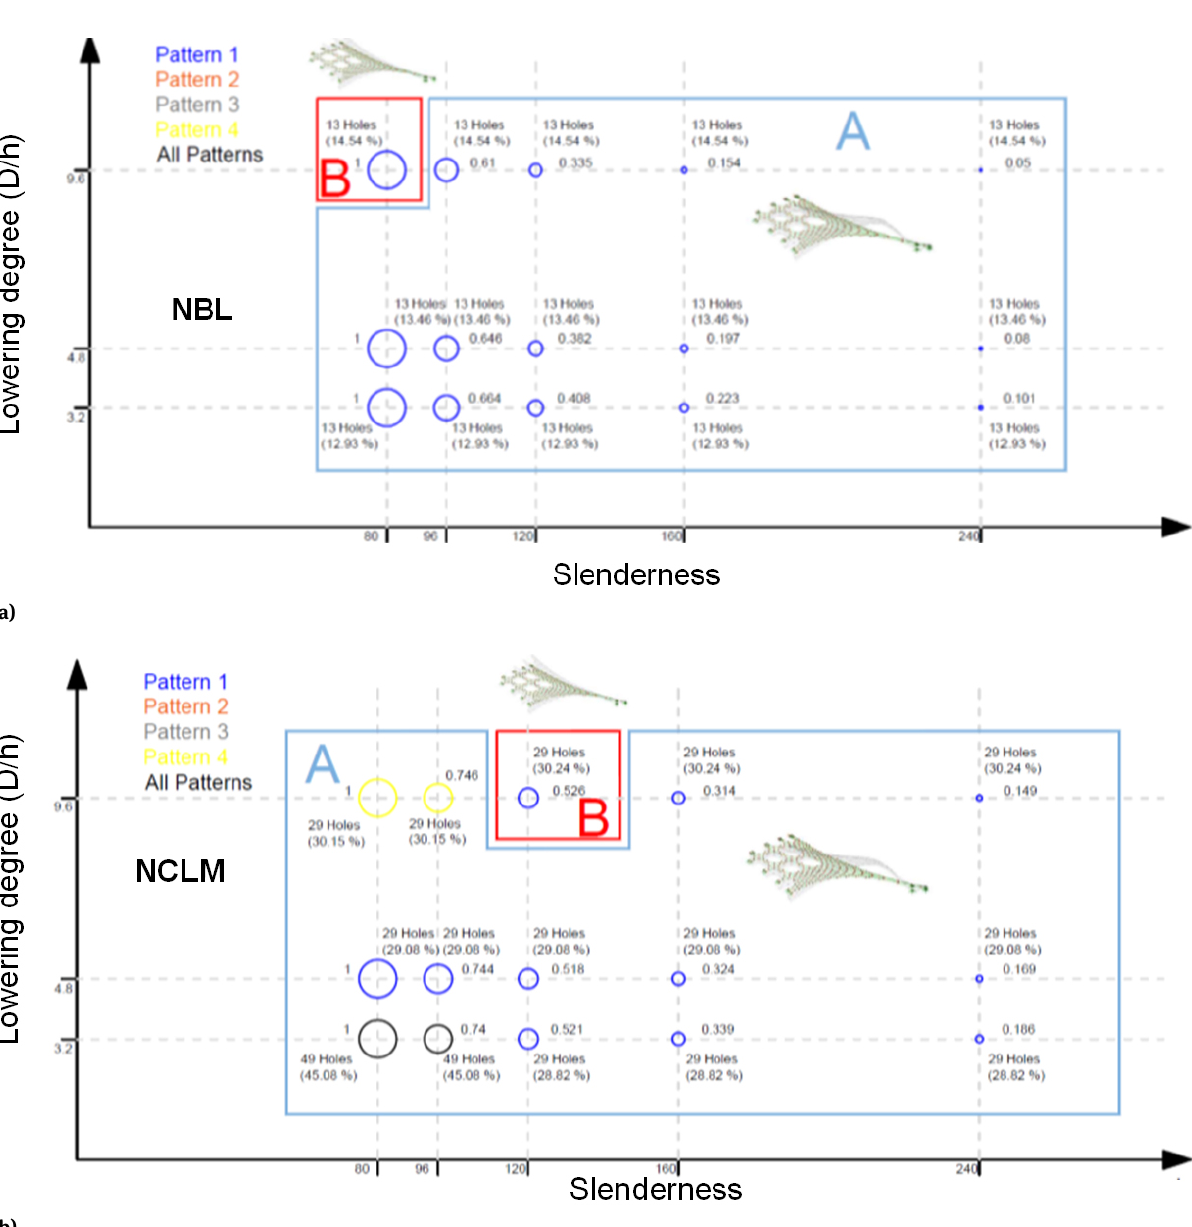
Figure 7: Normalized buckling load value (NBL), as regards the D / h (ranging from 3.2 to 9.0) and the slenderness ( 80 < λ < 240 ) are reported. For each value shown in the graph and represented by a circle, with color corresponding to the best pattern, the size of the indicator (circle) is proportional to the normalized value of the corresponding NBL (a). Normalized critical load multiplier (NCLM), as regards the D / h and the slenderness are reported. For each value shown in the graph and represented by a circle, with color corresponding to the best pattern, the size of the indicator (circle) is proportional to the normalized value of the corresponding NCLM